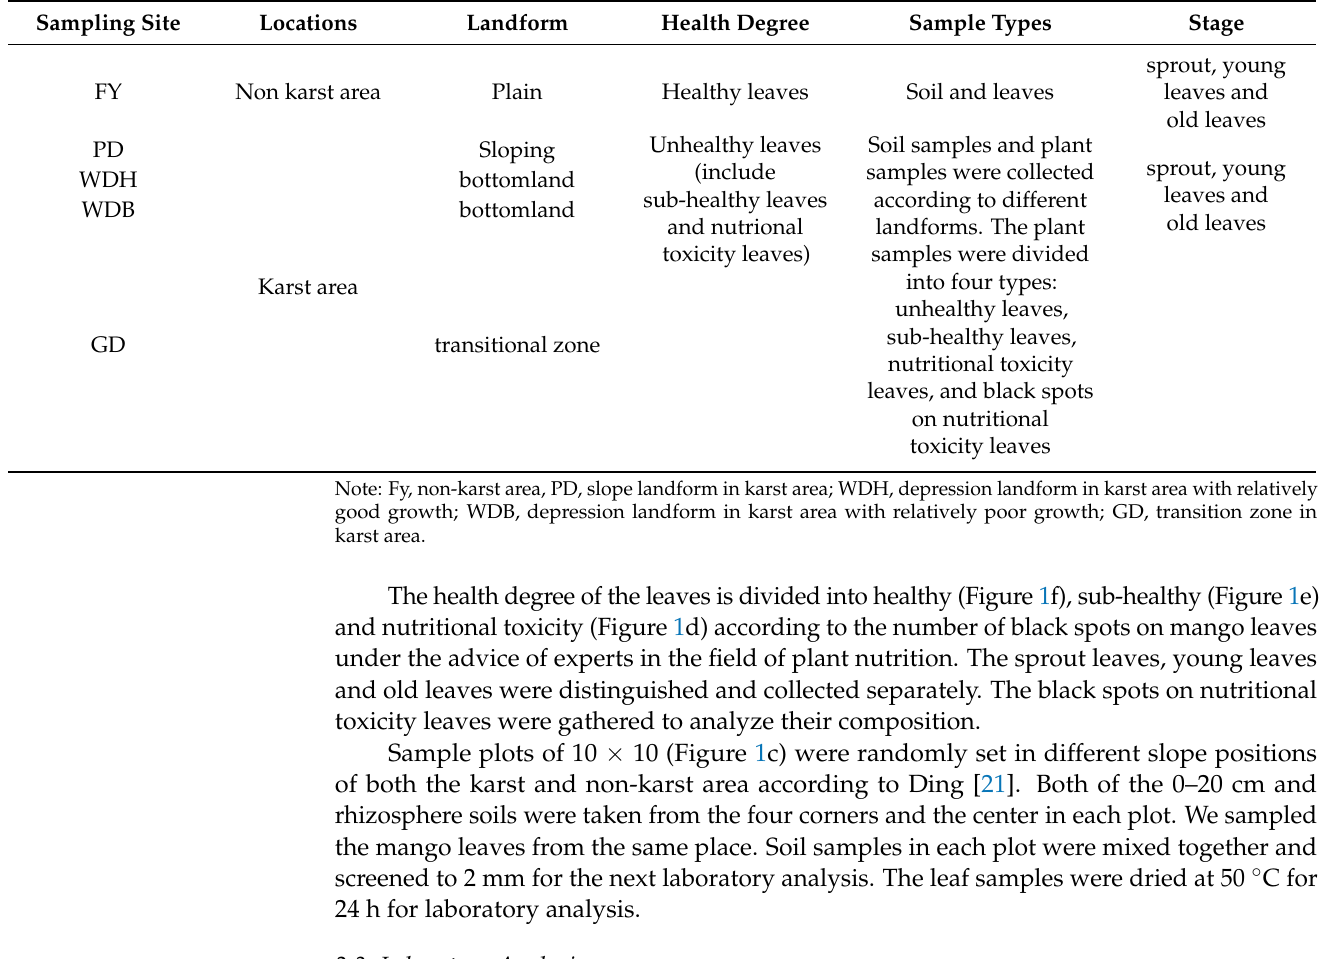
Table 1. The sample